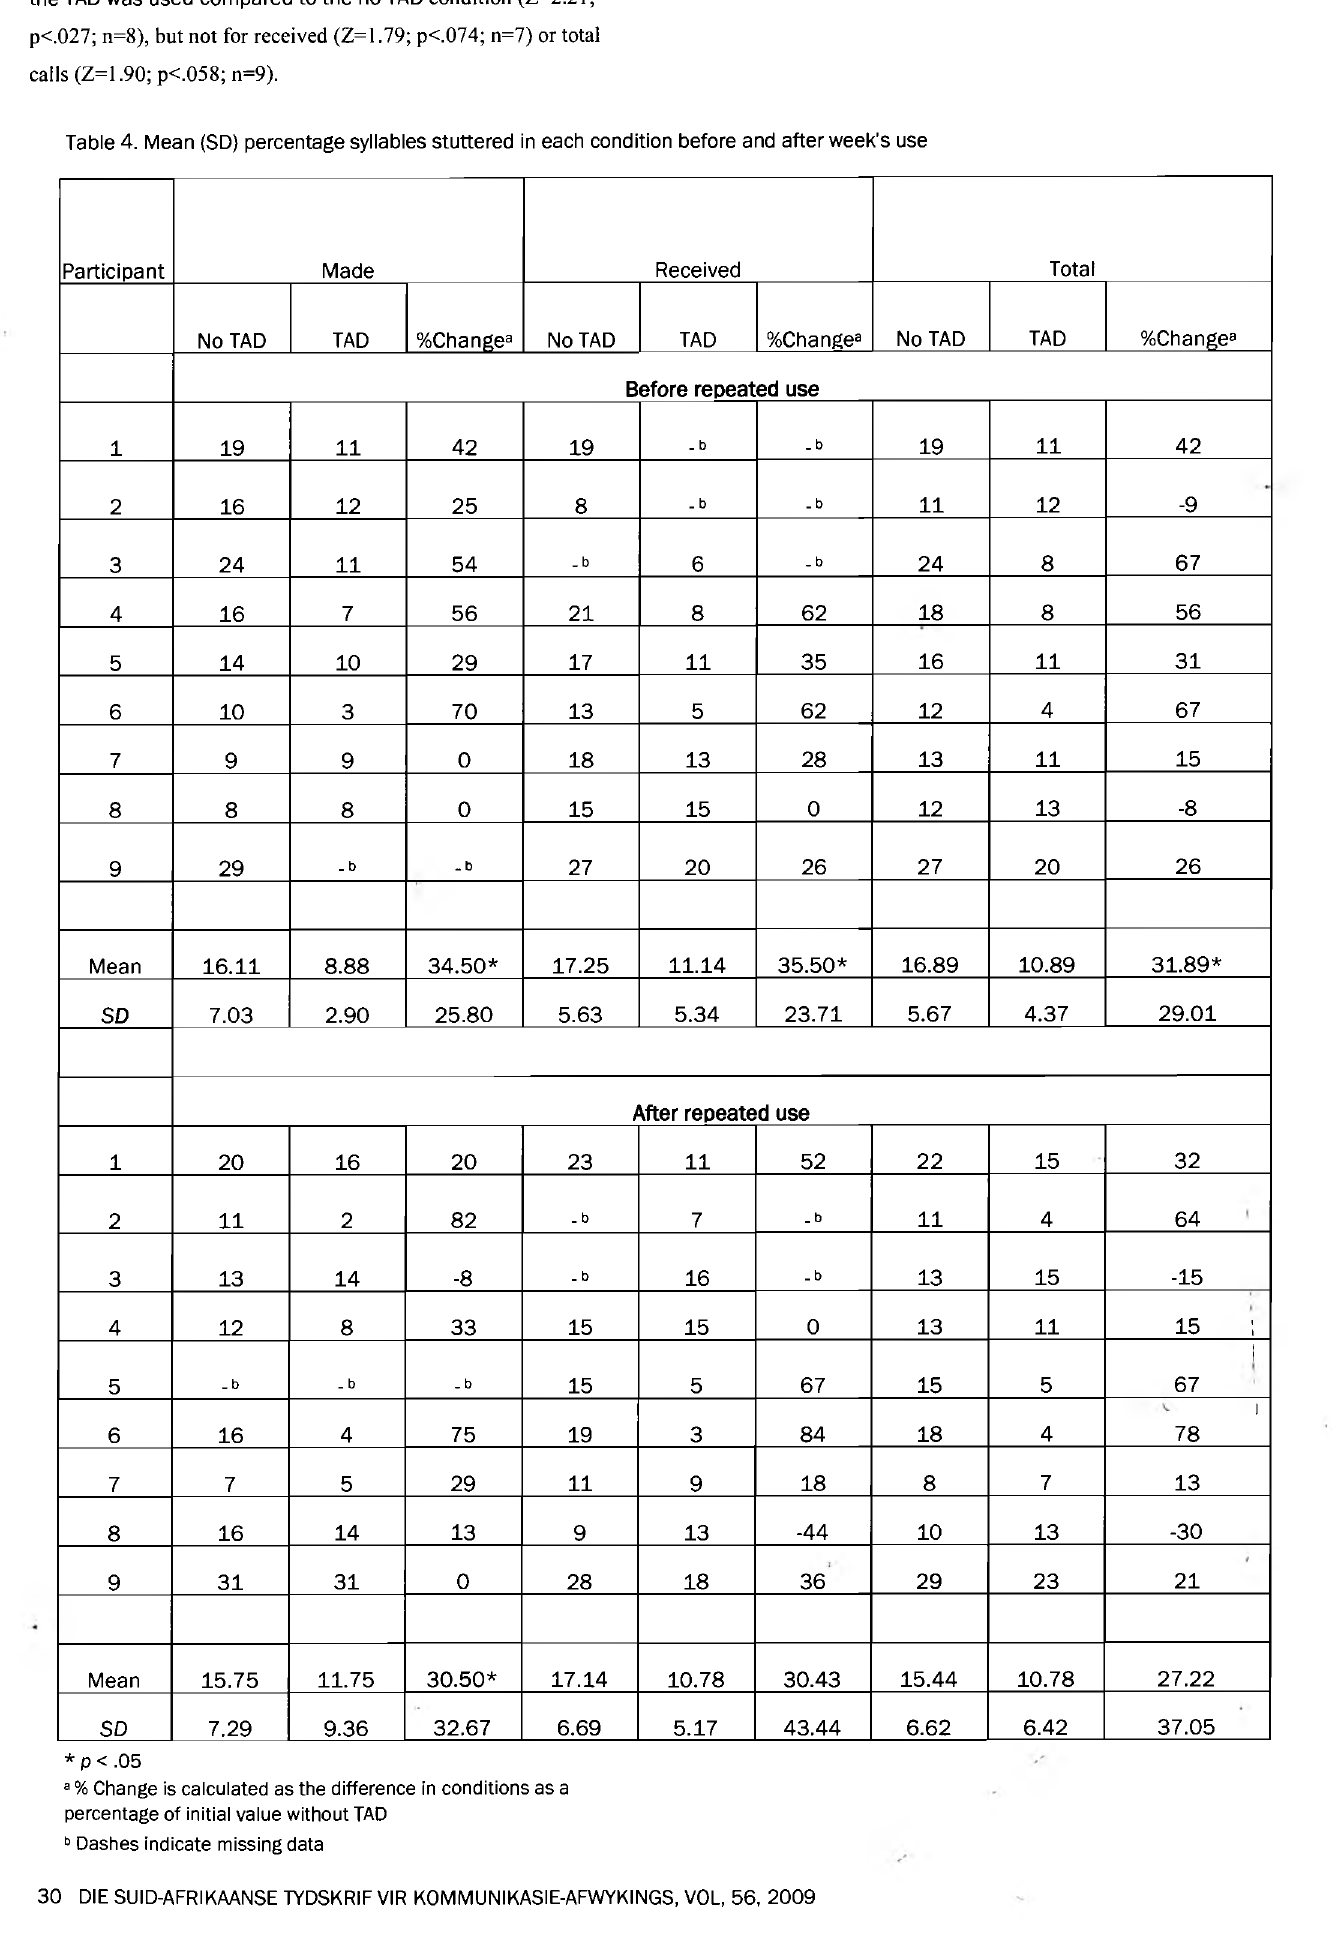
Table 4. Mean (SD) percentage syllables stuttered in each condition before and after week's use